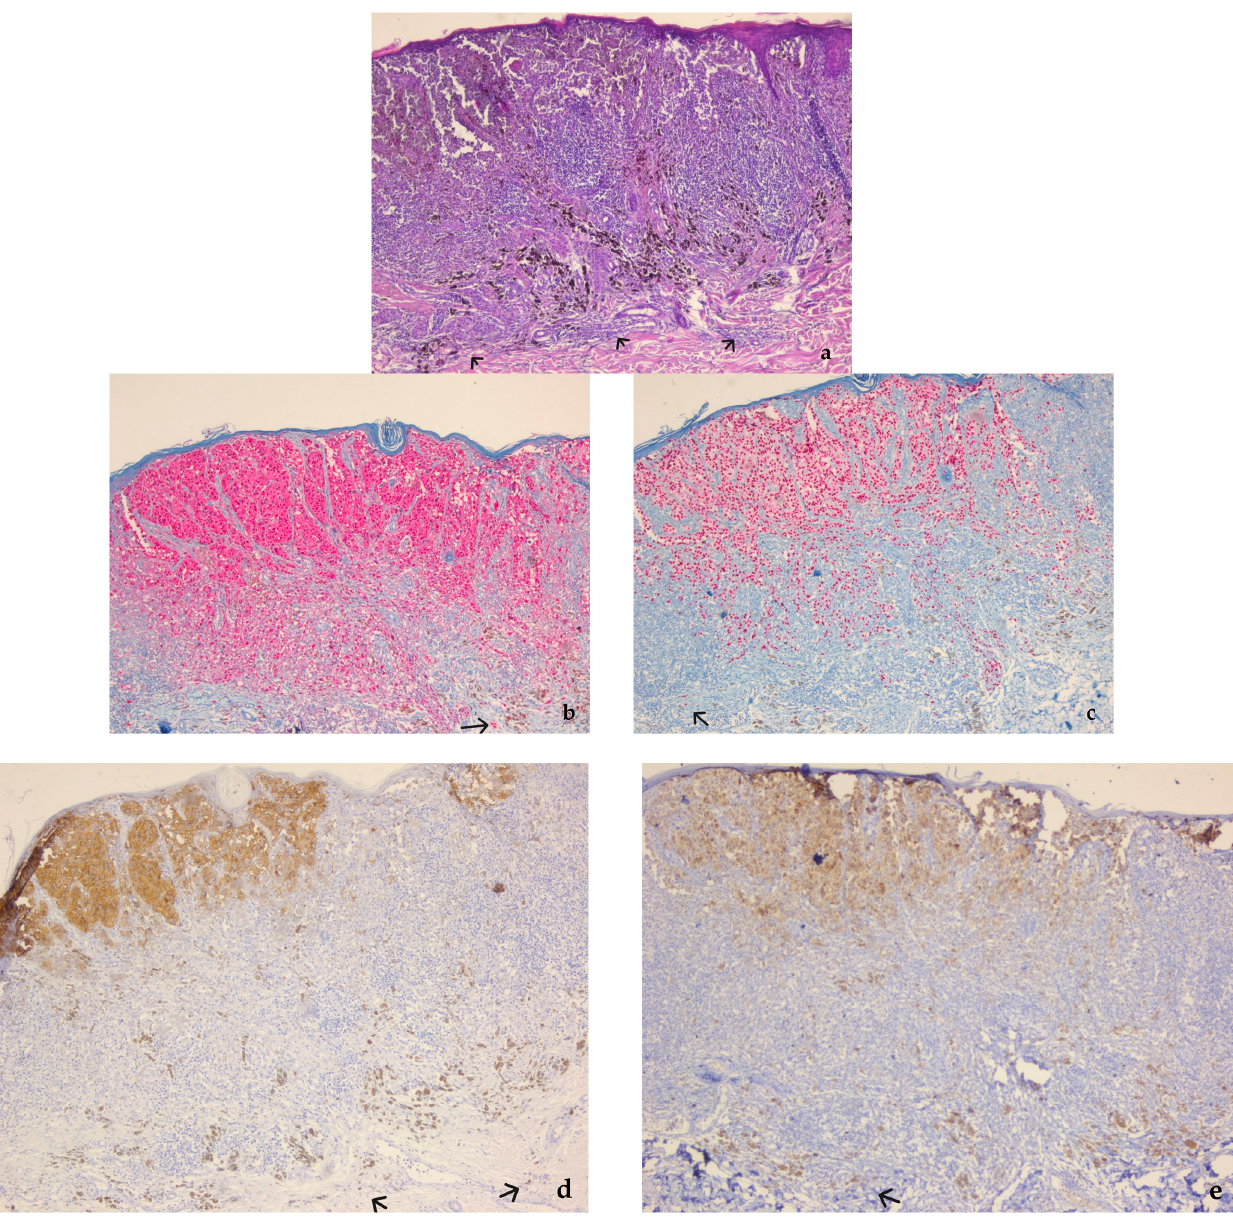
Figure 2. ( a ) Nodular melanoma, stage pT1a, in a 65-year-old male patient. The tumor is in the vertical growth phase; pagetoid spread and non-brisk TILs can be observed. The value of the Breslow thickness measured on HE was <0.8 mm; Clark level of invasion II. (HE, ×5). ( b ) The value of the Breslow thickness measured on S-100 was 1.0 mm, upstaging the tumor to pT1b. (S-100, ×5); ( c ) The value of the Breslow thickness measured on SOX10 was 1.0 mm. (SOX10, ×5). ( d ) The value of the Breslow thickness measured on HMB-45 was 0.9 mm. (HMB-45, ×5). ( e ) The value of the Breslow thickness measured on Melan-A was 0.9 mm. (Melan-A, ×5). Isolated tumor cells suggesting invasion are highlighted with black arrows (case from the archive of the County Clinical Hospital Mure ș ).